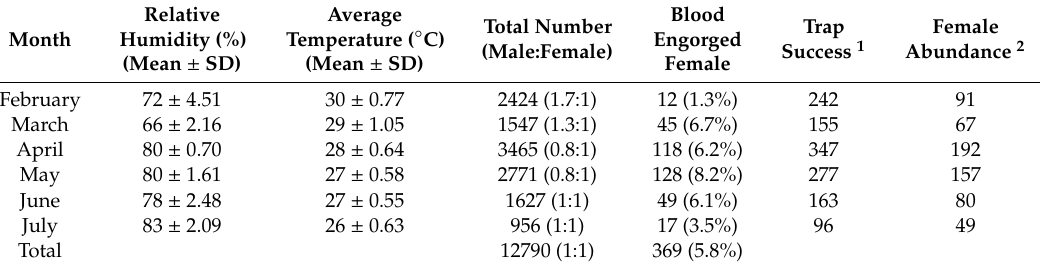
Table 1. Male-to-female ratio, trap success, and female abundance.